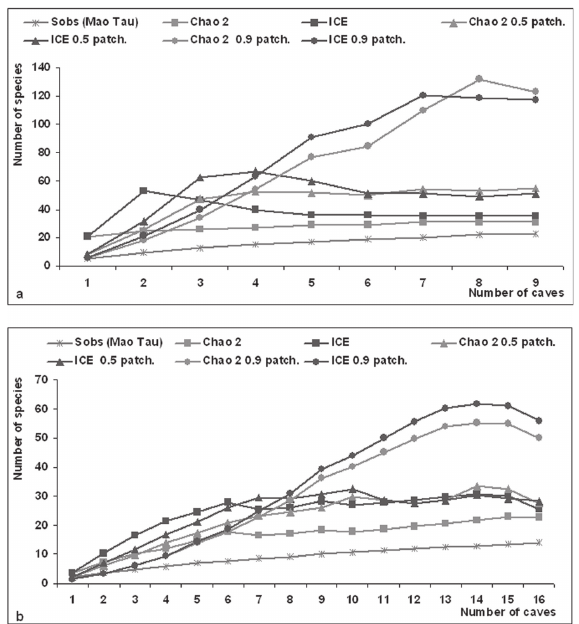
Figure 6 - Comparison of estimates of copepod species richness based on the cumulated data from five caves (UC, VC, LC, CC, DC) and from the database: a. epigean species (23 species, 9 caves); b. hypogean species (14 species, 16